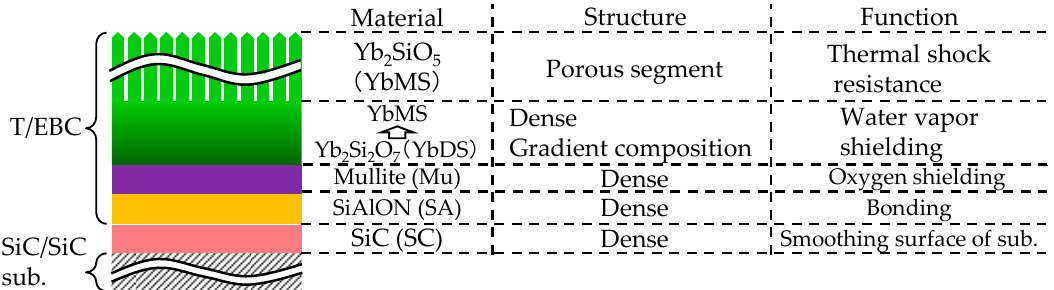
Figure 1. Schematic of thermal / environmental barrier coating (T / EBC) consisting of SiAlON (SA; bonding layer), mullite (Mu; oxygen shielding), layer of gradient composition of Yb 2 SiO 5 (YbMS) and Yb 2 Si 2 O 7 (YbDS) (Yb-silicate gradient composition layer; water vapor shielding) and top YbMS with porous segment structure (thermal shock